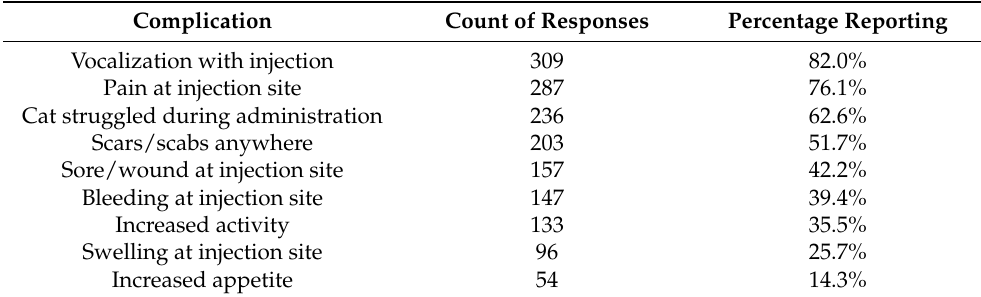
Table 7. Complications and adverse events reported for cats treated with GS-441524. Owners were able to list more than one source, so the total number of responses is higher than the total number of